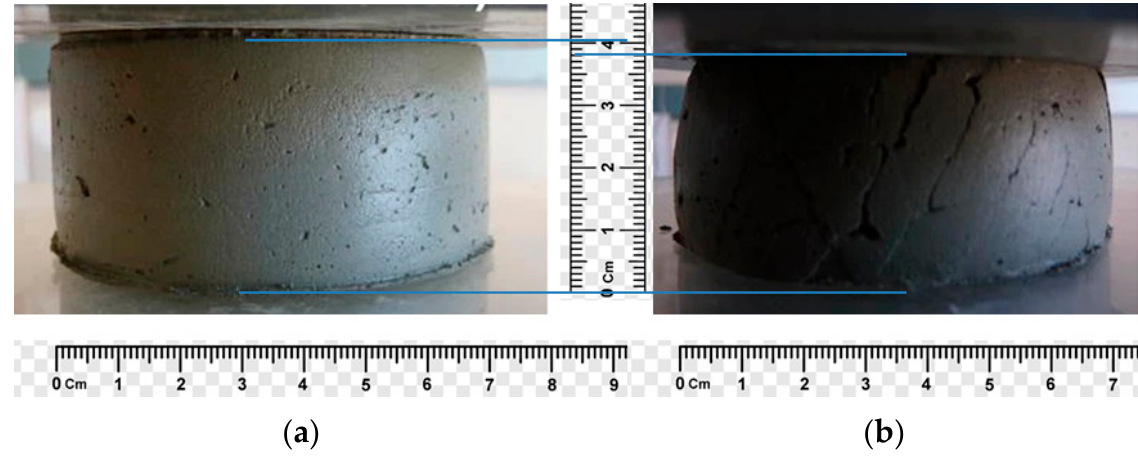
Figure 3. An example of determining the structural strength of extruded concrete, ( a ) the sample withstands the load (structural strength is provided), ( b ) the sample is destroyed.